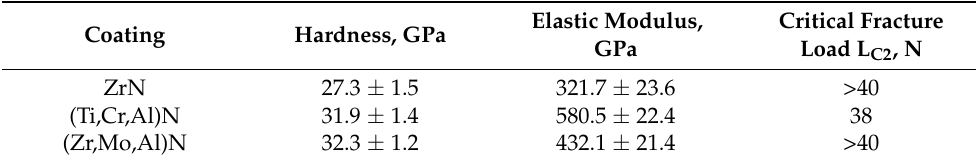
Table 1. Hardness, elastic modulus, and critical fracture load of the coatings.